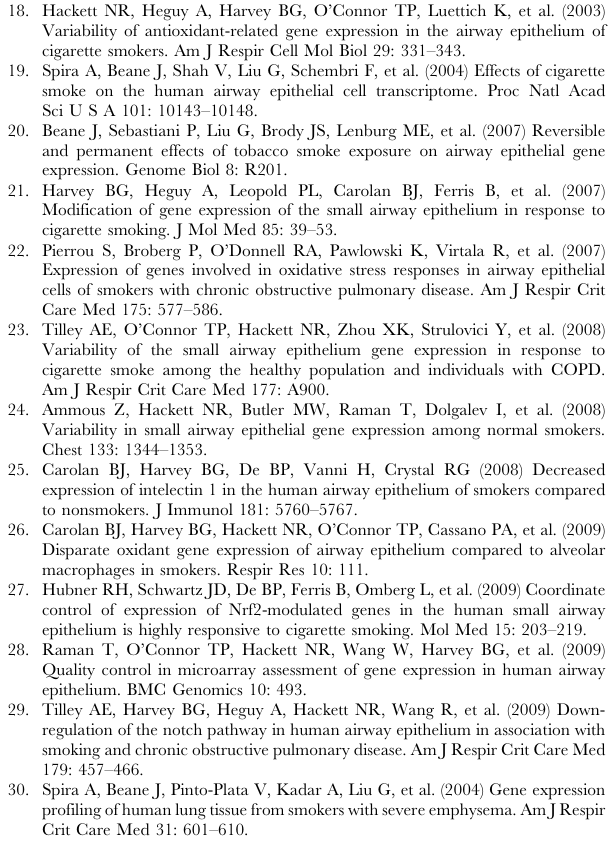
Table S7 Genes differentially expressed in the small airway epithelium of high responder healthy smokers vs low responder healthy smokers. Table S8 Genes differentially expressed in the small airway epithelium of COPD smokers vs low responder healthy smokers. Table S9 Genes differentially expressed in the small airway epithelium of COPD smokers and high respond- er smokers vs low responder